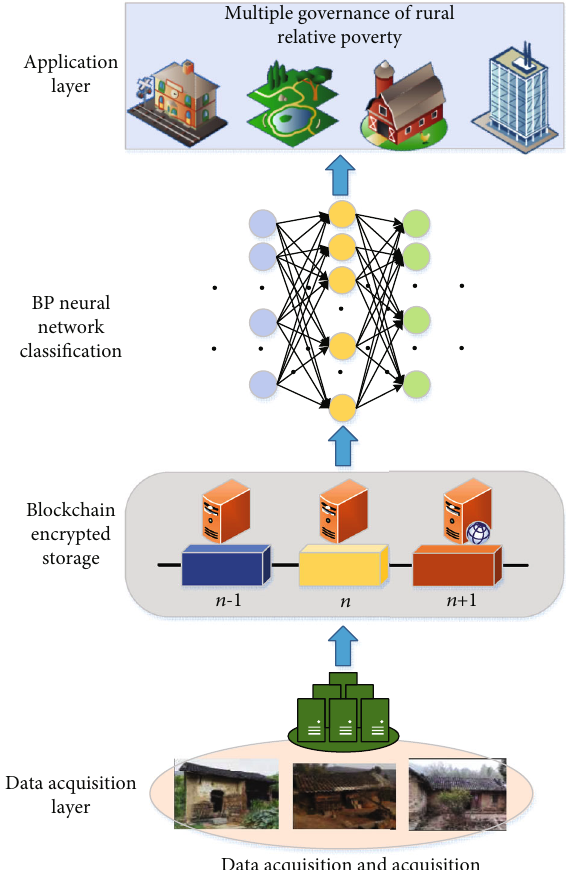
Figure 5: Schematic diagram of rural relative poverty collaborative governance of data visualization model based on blockchain combined with BP neural